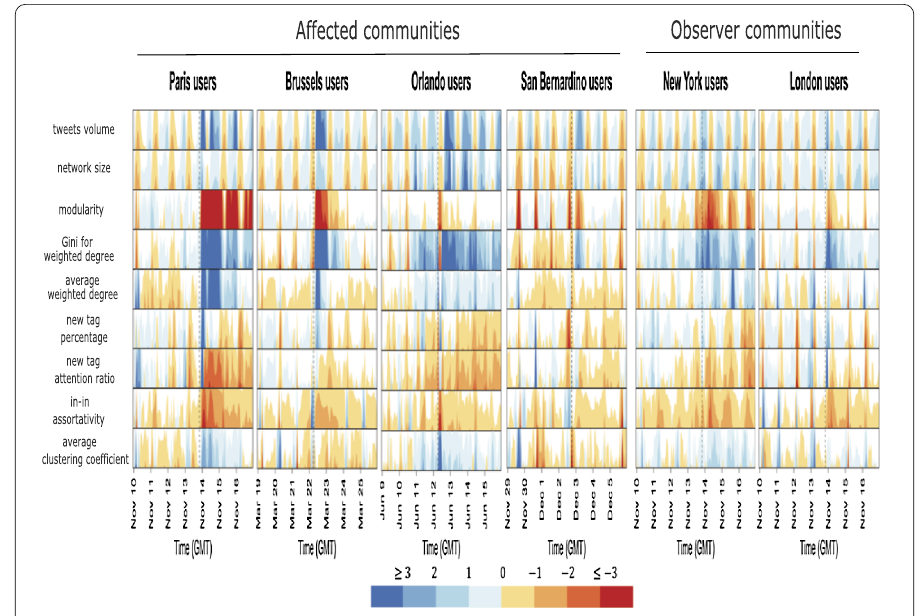
Figure 3 The changes of network metric values in attention shift networks during the event week. For each dataset, each row shows the values of a corresponding network metric with vertical color slices representing the deviation of the values from baseline statistics, on an hourly basis. Color shades represent the level of positive (blue) and negative (red) deviation (see Eq. 2). The black dashed lines in each column indicate the time of the